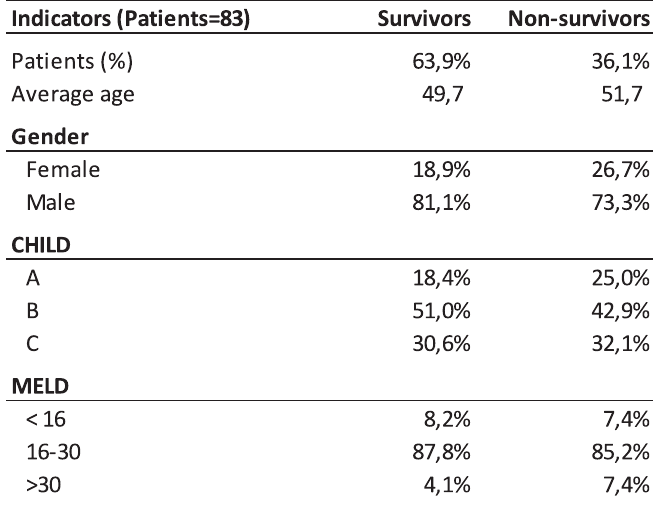
TABLE 1 – Demographic, clinical and etiologic data